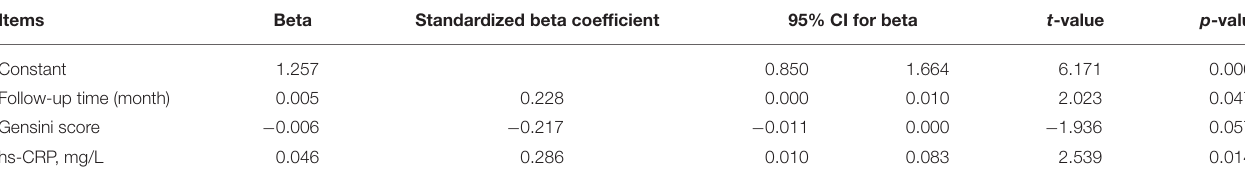
TABLE 4 | Results of Multiple linear regression for Gensini score fold changes.